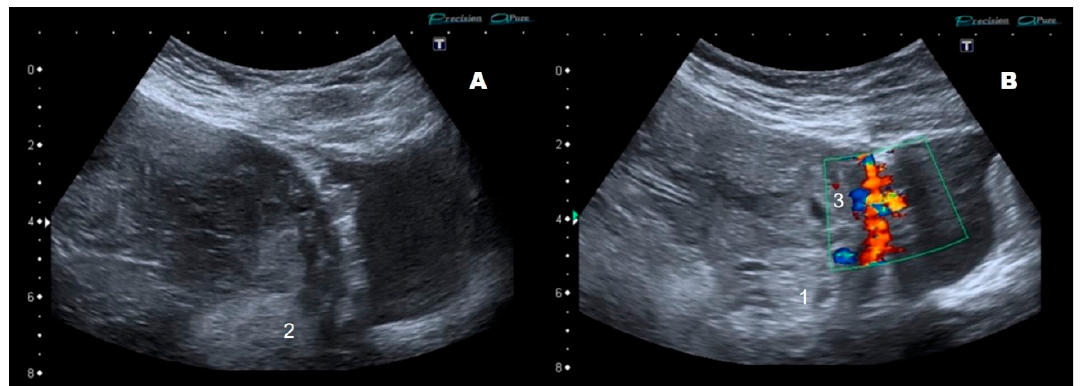
Figure 2. Ultrasound image ( A ): grey scale mode; ( B ): Doppler color mode. Placenta previa at 35 weeks of gestation. Ultrasound signs of placental accretism: (1) presence of placental lacunae, (2) myometrial thinning and loss of the clear zone, (3) increased retroplacental vascularization and bridging vessels to bladder wall.